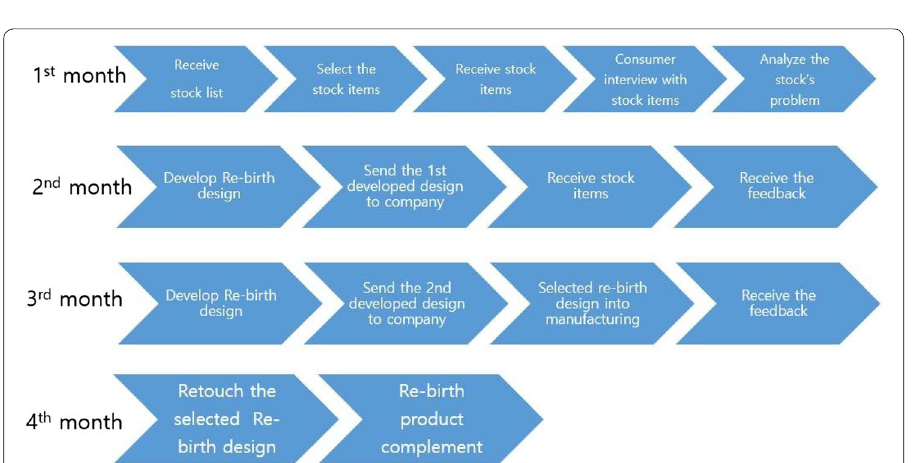
Fig. 2 Project procedure at design studio over 4